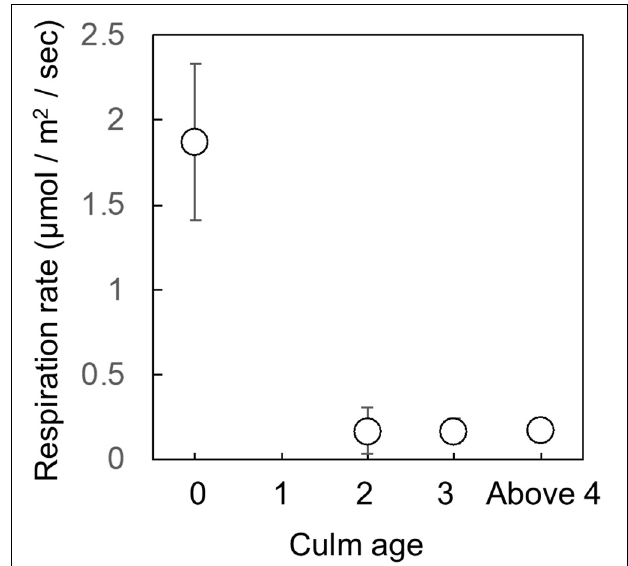
FIGURE 2 | Age variation of culm respiration rate. Respiration measurements were conducted on 1 day in June, before dawn. Two current year culms had very similar values and therefore their data on the figure appears as one dot. Data from two culms (3 and above 4-year-old) is missing due to equipment failure. The respiration rate of current year culm was significantly larger than those of other years culm ( p < 0.05, Kruskal-Wallis test).